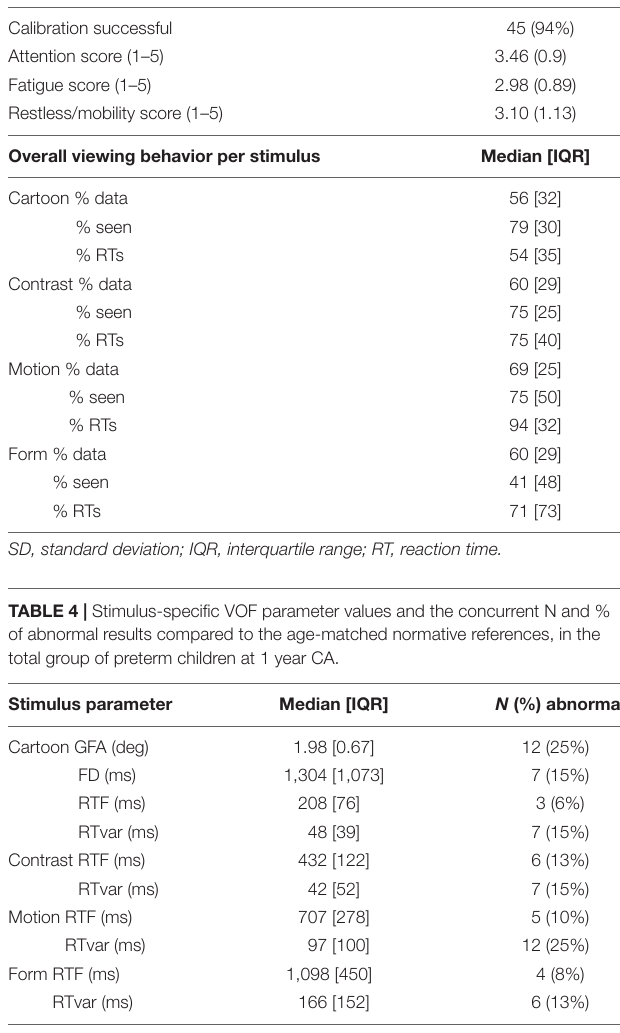
TABLE 5 | Results of the ophthalmic exam and VFA after referral in the children at risk of VPD, separately for the different types of VPD risks (based on neurological factors, based on VOF, or based on both